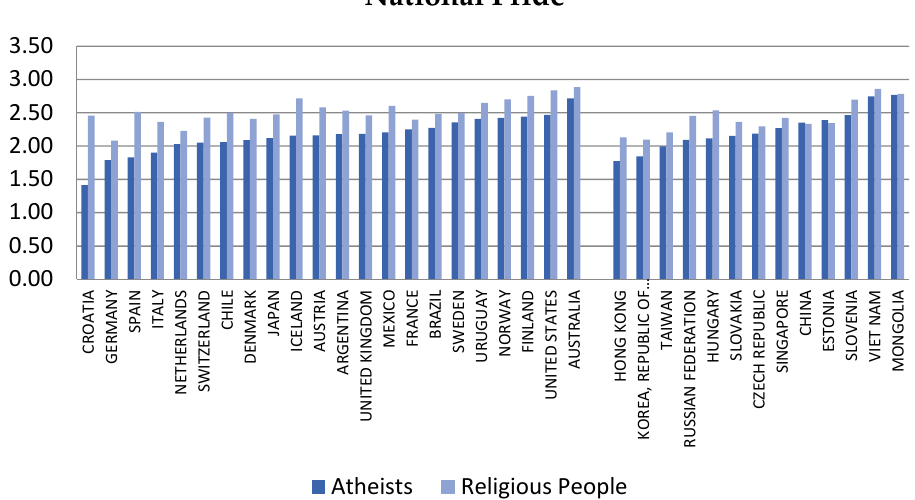
Figure 2. Mean national pride of atheists and religious people, numbers in Table A1 (Appendix A).